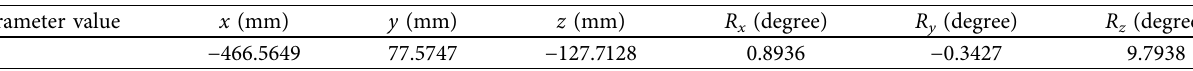
Table 3: The relationship between the O 0 coordinate of the robot and the O c coordinate of the camera.